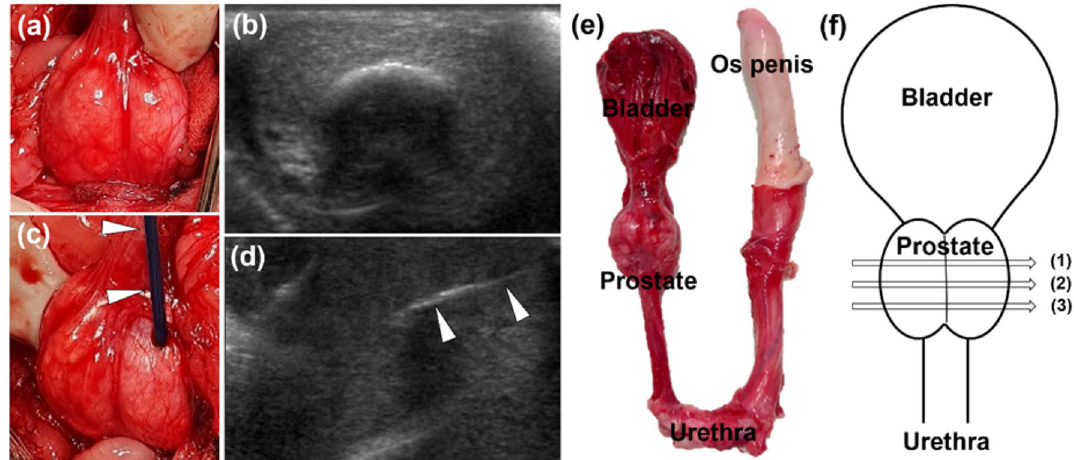
Figure 2. Technical steps in the irreversible electroporation (IRE) procedure using the bipolar electrode and pathologic findings and location of tissue samples examined histologically. ( a ) Photograph and ( b ) ultrasonographic view showing the prostate of a beagle dog before the IRE procedure. ( c ) Photograph and ( d ) ultrasonographic view showing the successful insertion of the bipolar electrode (arrowheads) into the left side of the prostate under ultrasonographic guidance. ( e ) Anatomy of the lower urinary tract of a beagle dog. ( f ) Schematic illustration showing the locations of proximal (1), middle (2), and distal (3) tissue samples ablated by